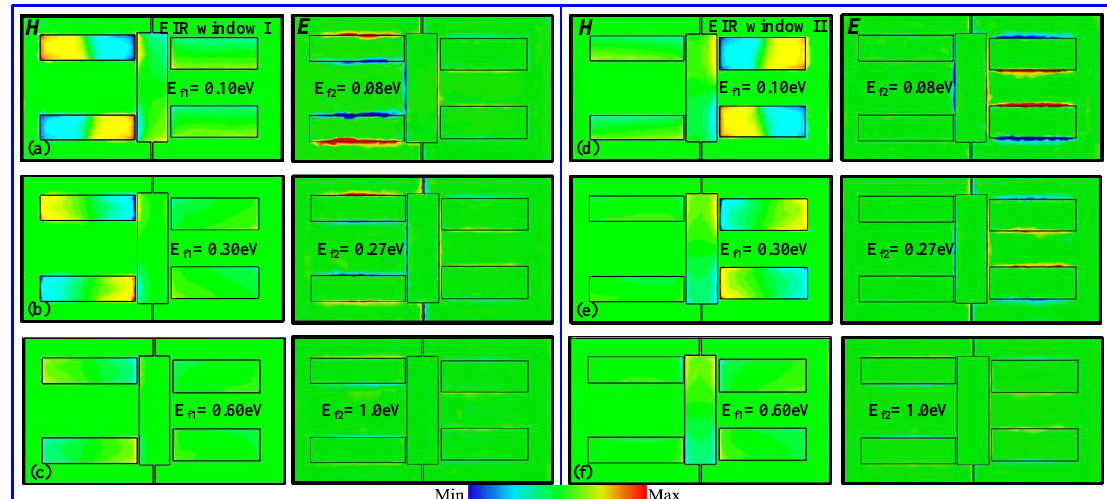
Figure 5. Magnetic and electric field distributions of two EIR windows at different Fermi energies: ( a ) E f1 = 0.10 eV and E f2 = 0.08 eV, ( b ) E f1 = 0.30 eV and E f2 = 0.27 eV, and ( c ) E f1 = 0.60 eV and E f2 = 1.0 eV for EIR Window I and ( d ) E f1 = 0.10 eV and E f2 = 0.08 eV, ( e ) E f1 = 0.30 eV and E f2 = 0.27 eV, and ( f ) E f1 = 0.60 eV and E f2 = 1.0 eV for EIR Window II.